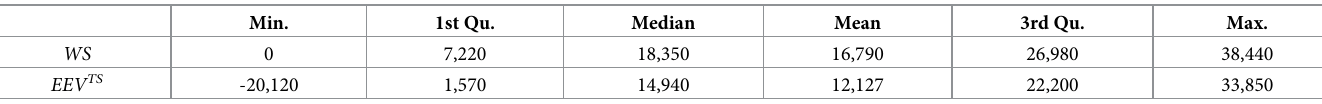
Table 2. Basic statistics for WS and EEV TS objective values